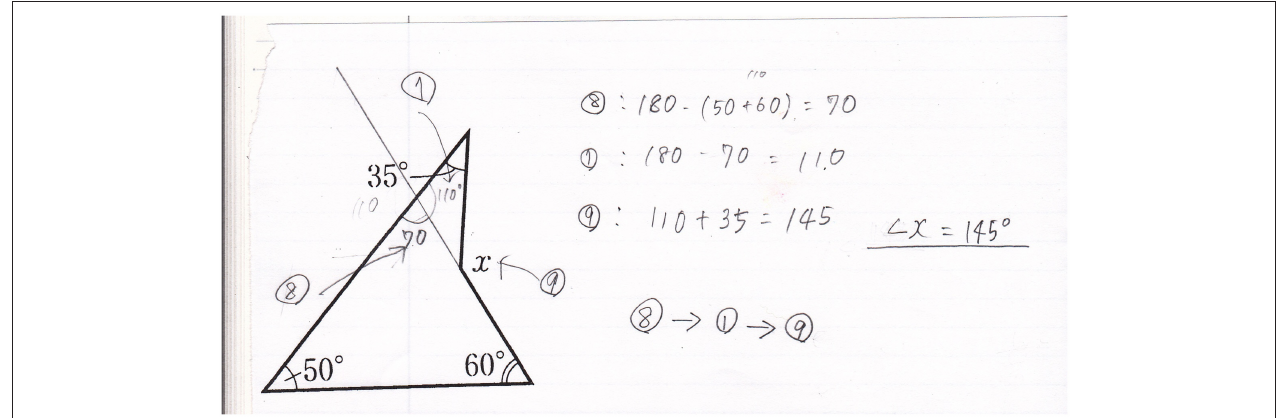
FIGURE 6 | Typical explanation by